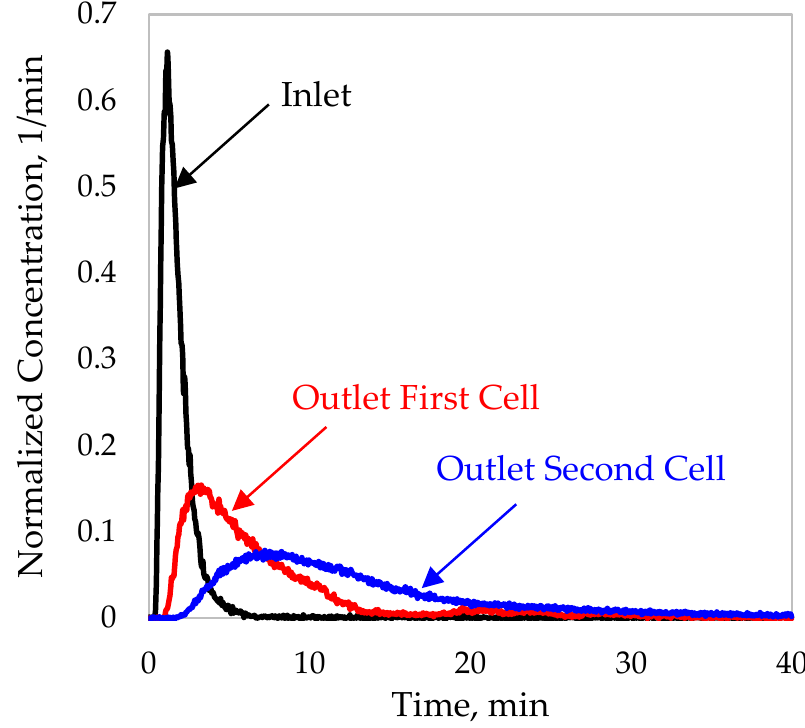
Figure 4. Normalized tracer concentrations in the inlet and outlet of the first and second cells of the rougher bank A, liquid tracer.